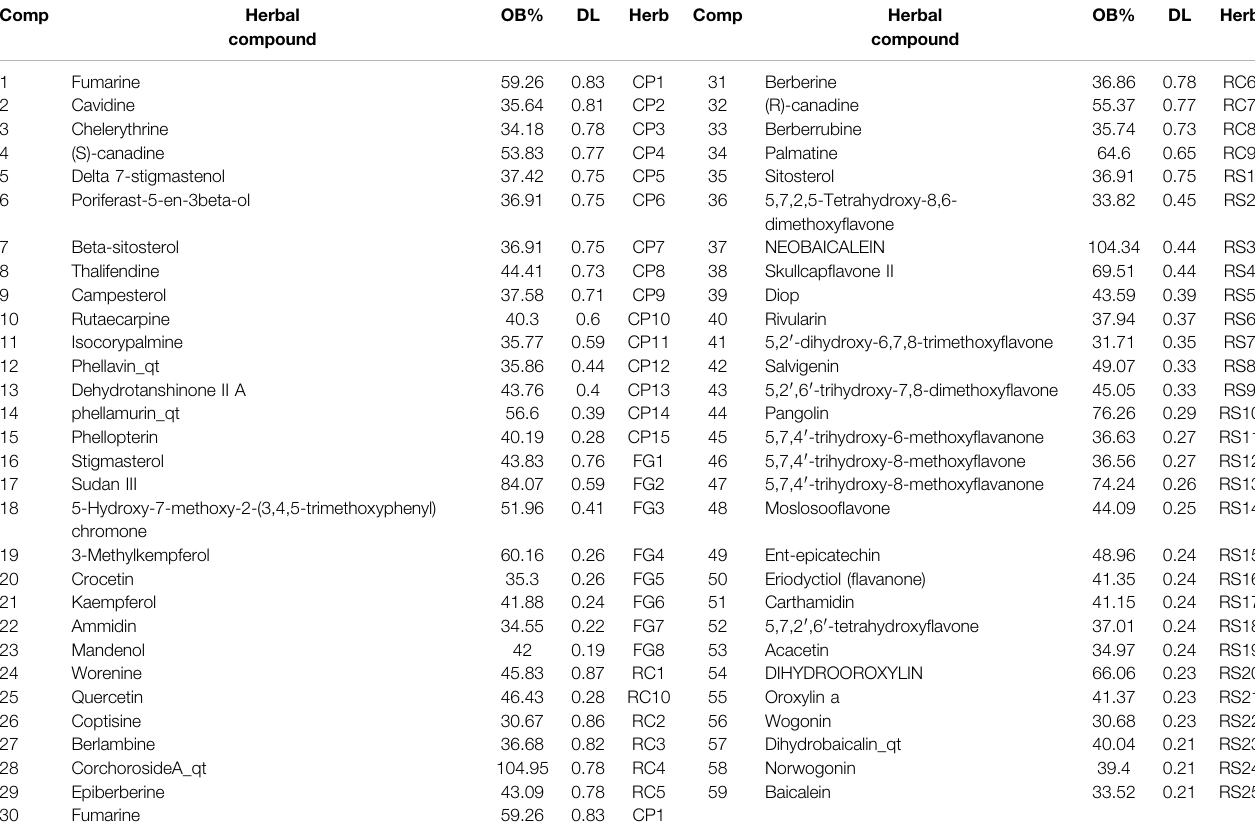
TABLE 1 | Compounds in HLJDT with oral bioavailability (OB) larger than 30% and drug-likeness (DL) larger than